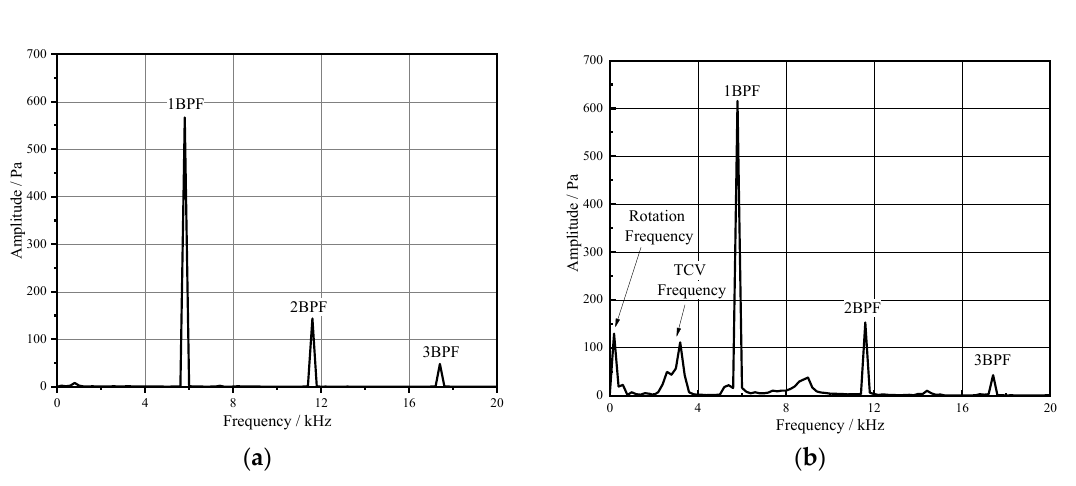
Figure 19. Pressure spectrum in front of LE under design clearance model. ( a ): under PE condition. ( b ): under NS condition.